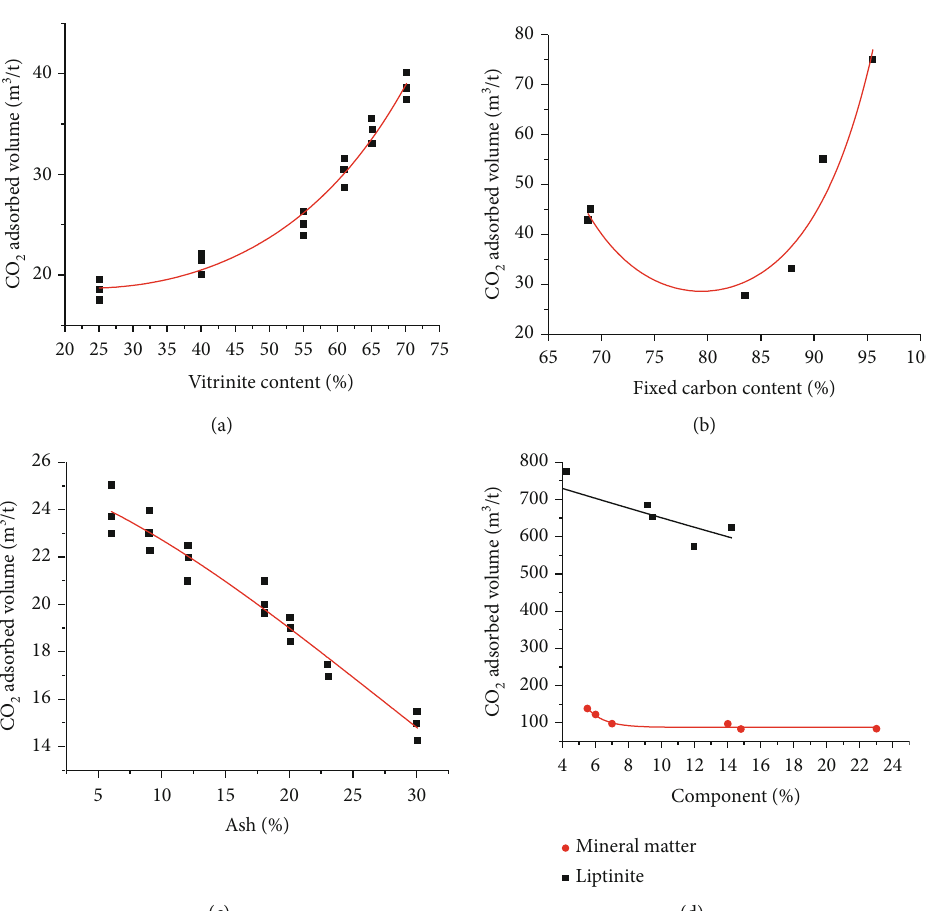
Figure 14: Relationships between CO adsorption capacity and maceral composition and coal composition, and the variation of Langmuir 2 parameters with vitrinite re fl ectance of tectonic/intact coals (e, f) (modi fi ed from Bustin and Clarkson [17], Levy et al. [102], and Faiz et al. [103]).